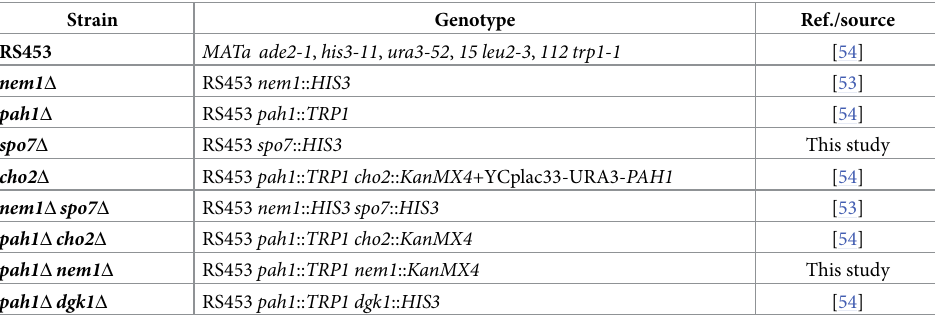
Table 1. Yeast strains used in this